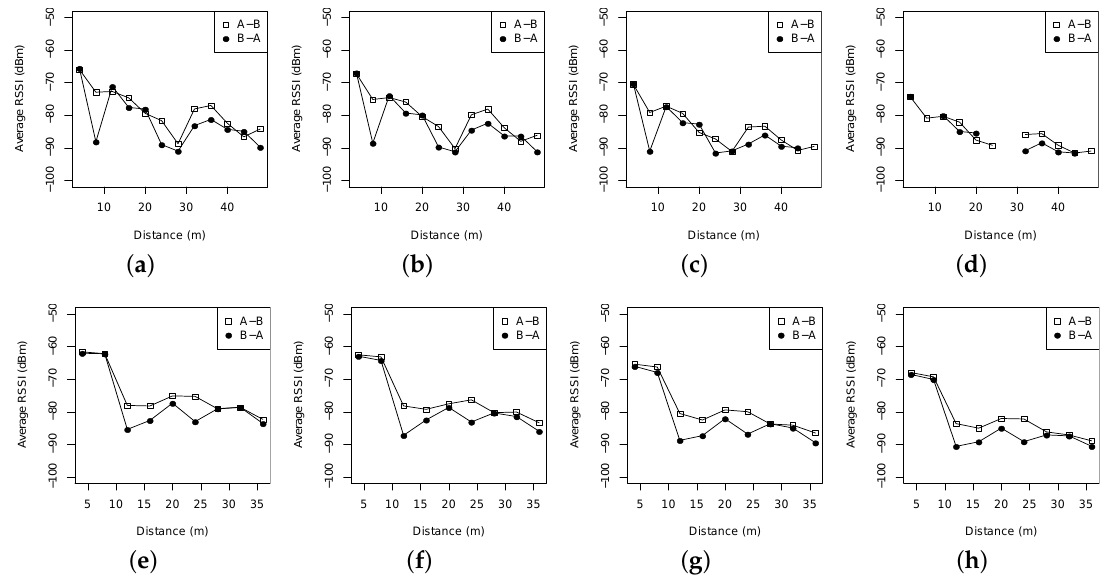
Figure 2. RSSI distributions vs. distances with different transmit powers under two different forests. ( a ) Bajia, tx = 31; ( b ) Bajia, tx = 27; ( c ) Bajia, tx = 19; ( d ) Bajia, tx = 15; ( e ) Campus, tx = 31; ( f ) Campus,